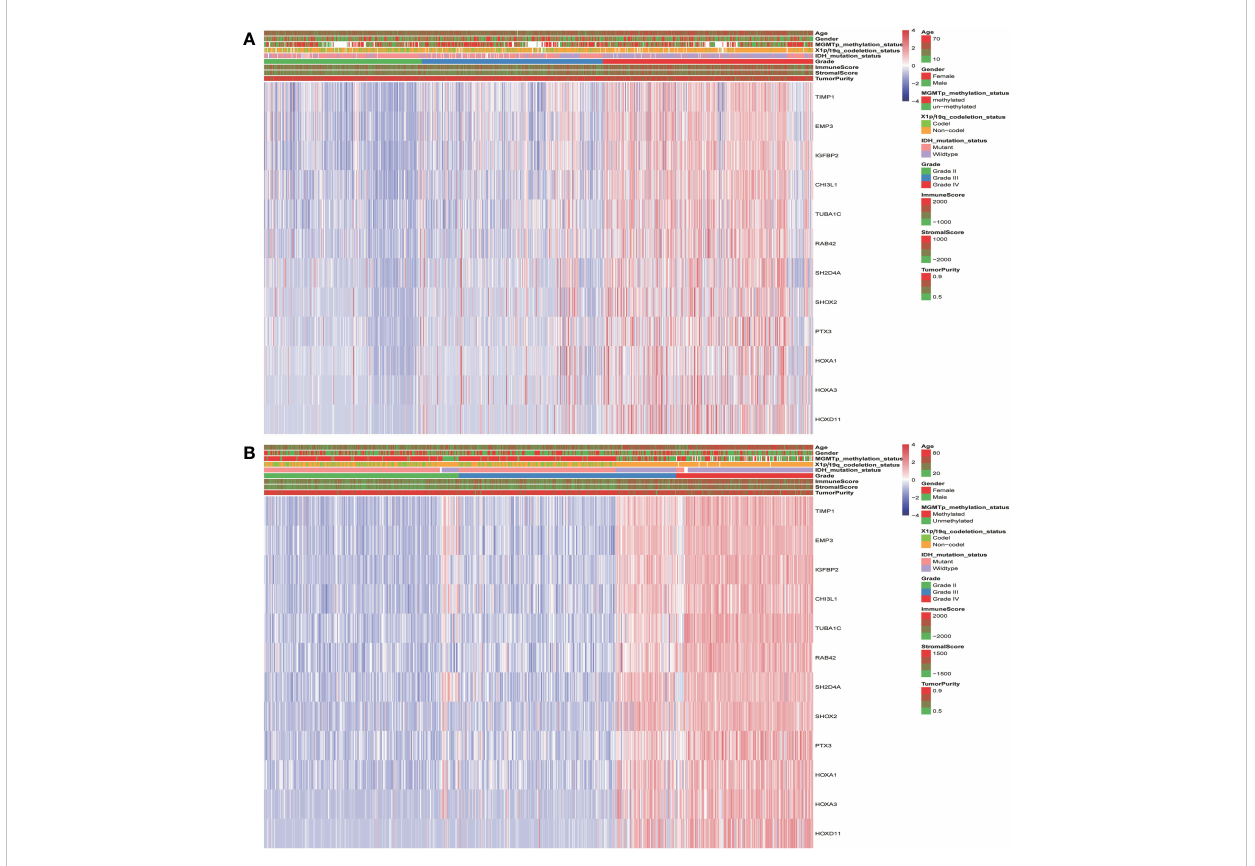
FIGURE 5 The landscape of glioma clinical, immune score, and molecular characteristics in association with the expression of key genes in TCGA (A) and CGGA (B)